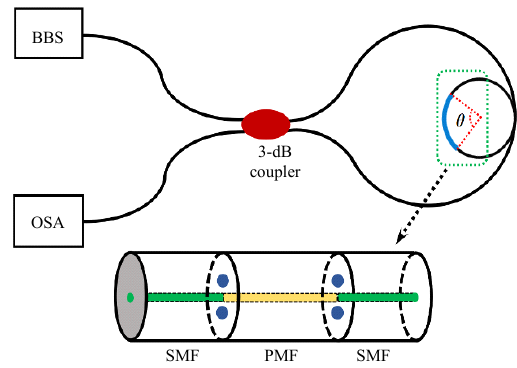
Fig. 1 Schematic diagram of Saganc interferometer based on a polarization maintaining fiber with a